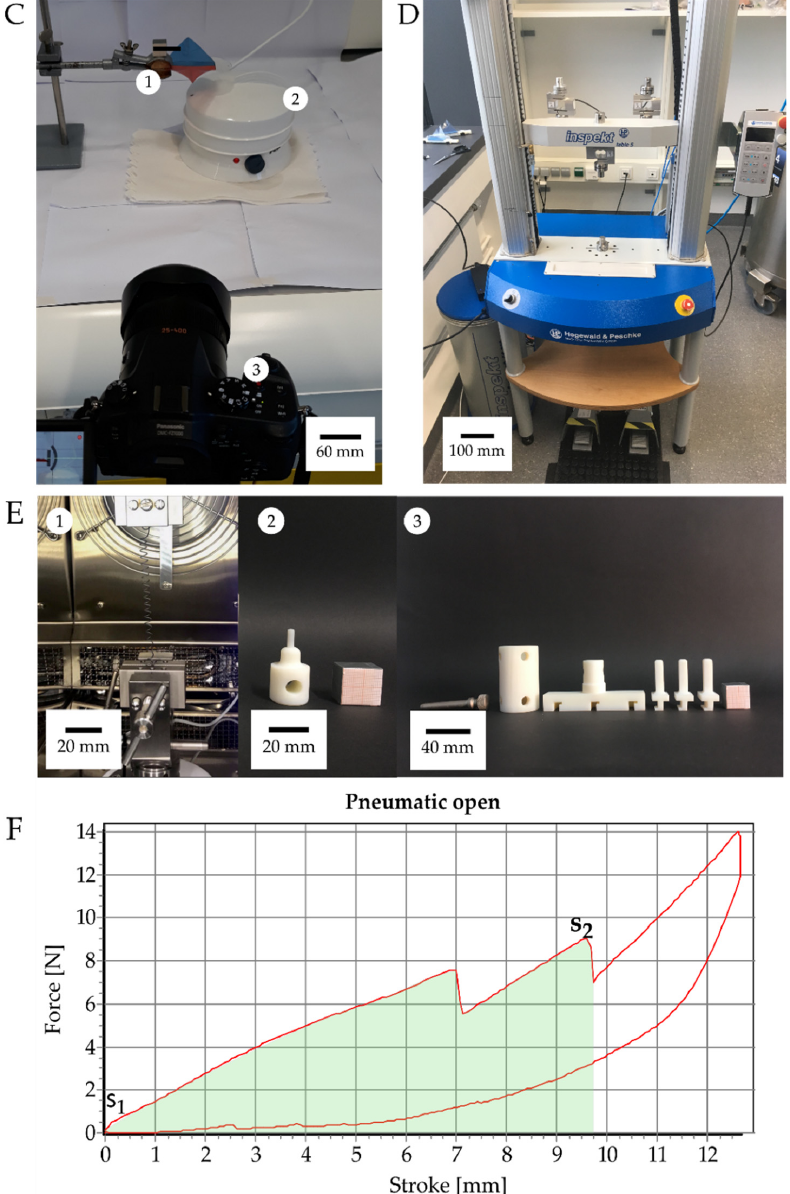
Figure 2. Characterization setups. High-speed videos were recorded in a specifically build recording chamber ( A ) with two highspeed cameras ( A1 ) positioned at a 90 ◦ angle to each other. Light is provided by two high-power flicker-free LED light sources ( A2 ) that point at the object of interest ( A3 ). The Venus flytrap and the pneumatic and the magnetic demonstrators were recorded using this setup.The SMA actuated demonstrators were tested by placing them in a temperature chamber ( B1 ). Three demonstrators were tested simultaneously ( B2 ). The movement of the springs and the lobes of the demonstrator were recorded by two cameras ( B3 ) for later analysis. For actuation of the hydrogel- based demonstrator ( C1 ), a hot water vapour source ( C2 ) provided enough humidity to unlock the demonstrator, which was filmed by a camera for kinematic analysis ( C3 ). Force-displacement measurements were performed with specific test mounts by the Hegewald and Peschke Inspekt Table 5 ( D ). The output force for each SMA spring was measured ( E1 ) at 63 ◦ C. To mimic the actuation procedure, specific mounts were designed to apply pressure in the direction of actuation in the demonstrator (magnetic ( E2 ) and pneumatic ( E3 )). An exemplary force displacement curve of an opening event of the pneumatic system is shown in ( F ). S 1 and S 2 indicate the lower and upper end, respectively, of the integral (green area) used for calculating the kinetic energy necessary to open the the two lobes (lobe openig indicated in the curve by the two sudden force